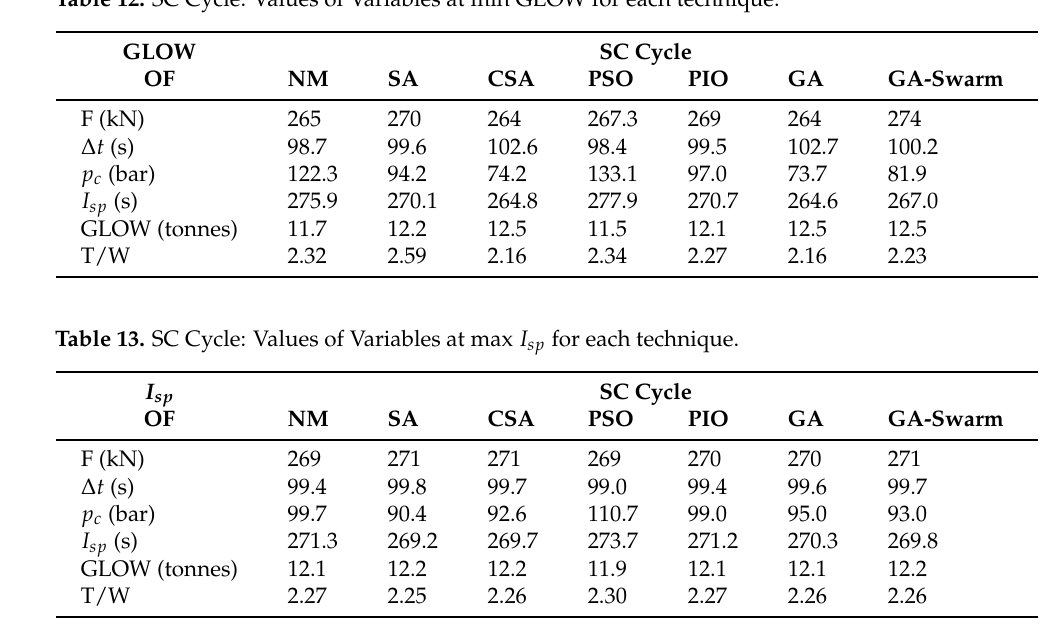
Table 12. SC Cycle: Values of Variables at min GLOW for each technique. GLOW OF